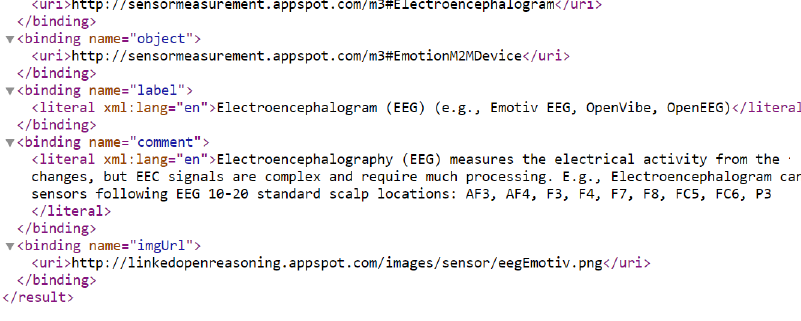
Figure 4. Web service to retrieve all emotion